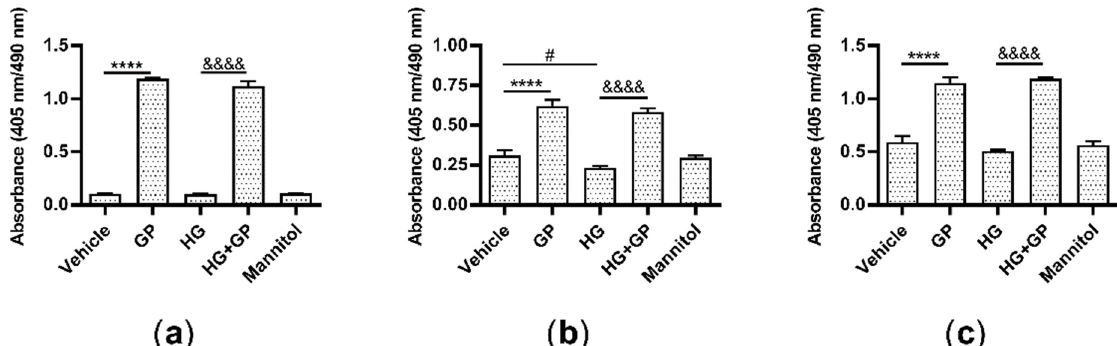
Figure 7. G. procumbens promotes the proliferation of human keratinocytes, fibroblasts and endothelial cells under diabetic conditions: ( a ) Primary human keratinocytes, ( b ) fibroblasts and ( c ) endothelial cells were pretreated with 38 mM glucose (high glucose) or 38 mM mannitol for 24 h and then stimulated with 50 μ g/mL G. procumbens (GP) or 0.1% DMSO in normal medium (Veh: vehicle) or 0.1% DMSO in high-glucose medium (HG) for 48 h. Cell proliferation was assessed using a 5-bromo-2 ′ -deoxyuridine (BrdU) Labeling and Detection Kit III. Values are presented as the mean ± SD of four independent experiments. **** p < 0.0001 for the comparison between vehicle and G. procumbens (GP) in normal medium. &&&& p < 0.0001 for the comparison between vehicle (HG) and G. procumbens (HG+GP) in high-glucose medium. # p < 0.05 for the comparison between vehicle in normal medium and vehicle in high-glucose medium (HG).